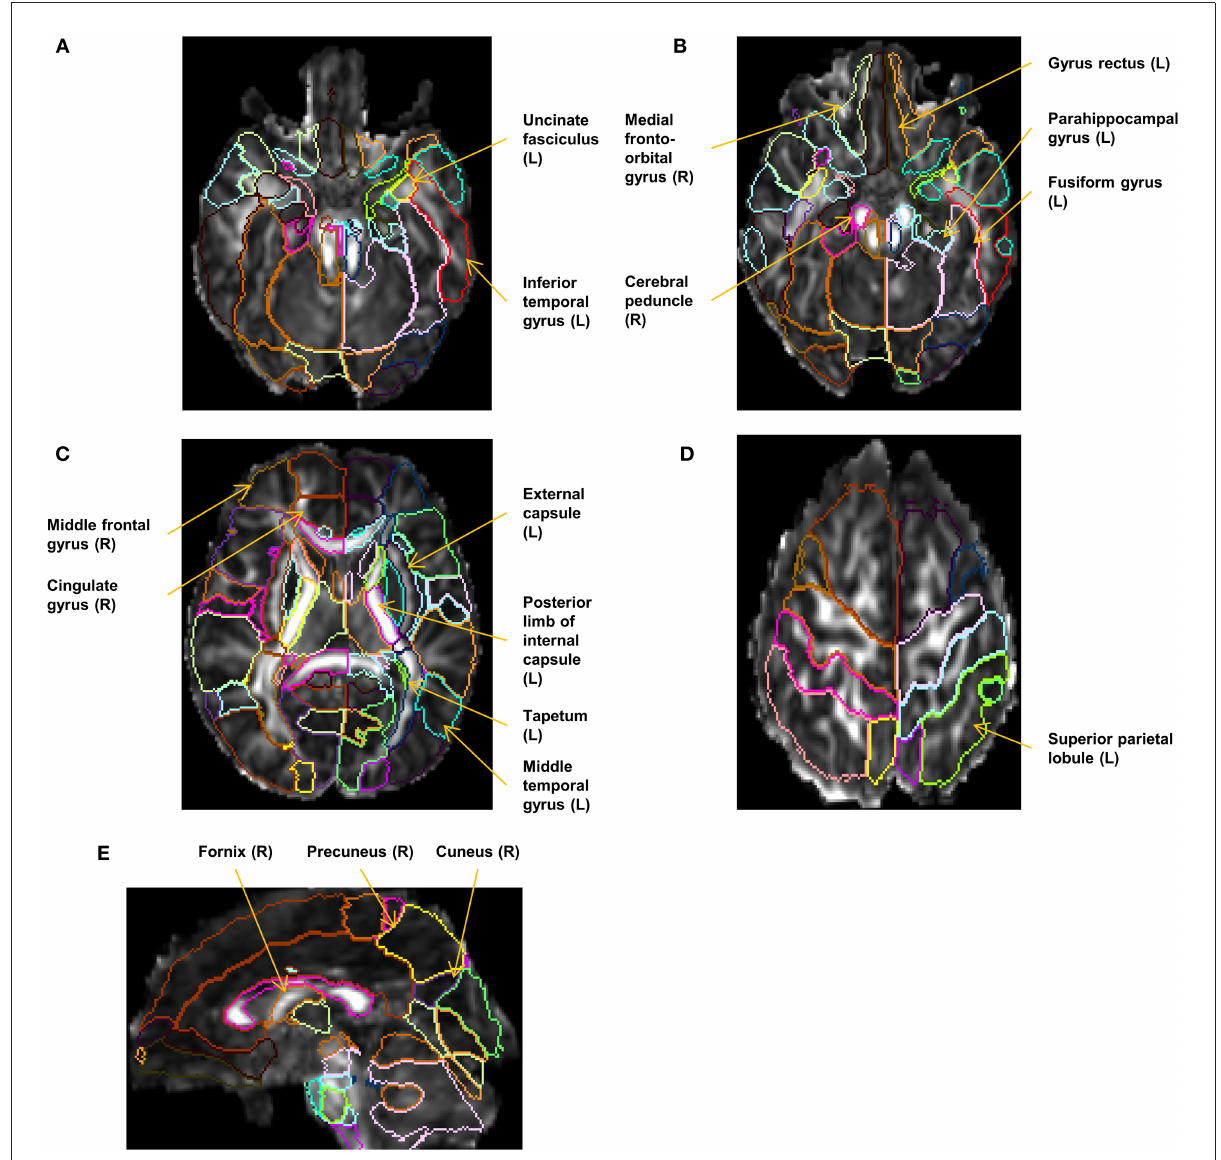
FIGURE2 Representative parcellation maps superimposed on FA maps. The locations and laterality (L/R) of the selected 17 structures in the cDTI score calculation are annotated. (A–D) Axial images at the level of the corticospinal tract, the uncinate fasciculus (A) , the cerebral peduncle (B) , the basal ganglia (C) , and the superior parietal lobule (D) . (E) A sagittal image at the level of the right fornix and the right